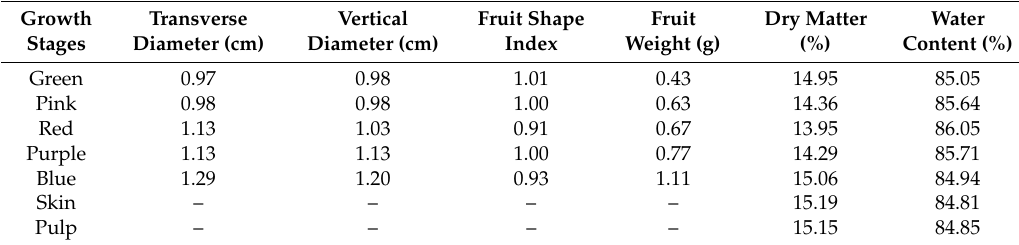
Table 1. Basic physical properties of blueberry fruit at different developmental